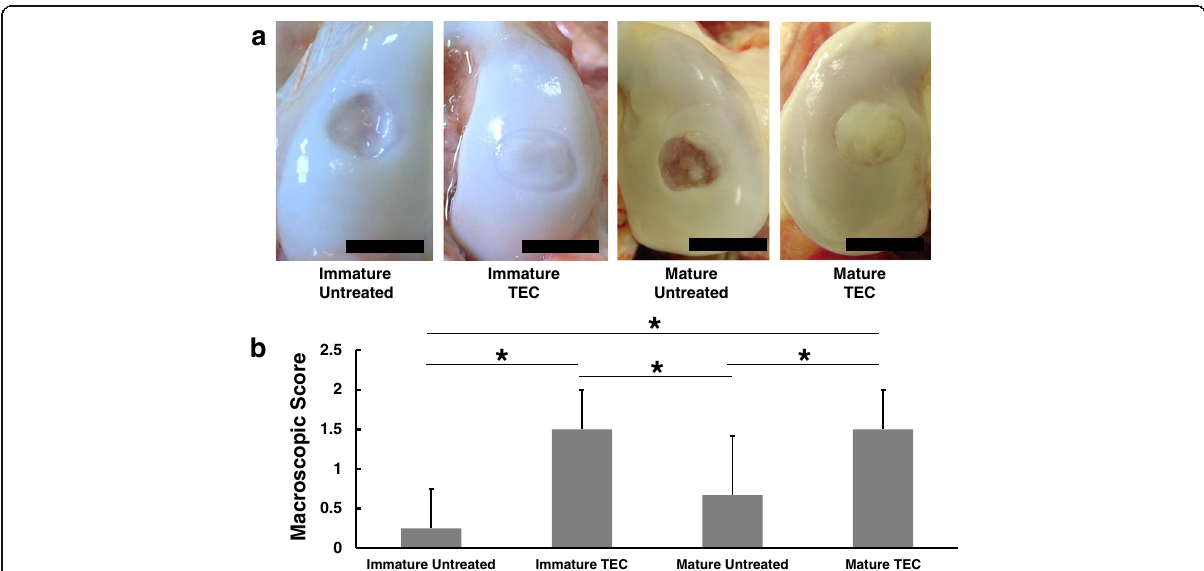
Fig. 3 a Macroscopic view of a chondral lesion treated with or without TEC at 6 months post-implantation. Bar = 10 mm. b Macroscopic score of the repair tissue at 6 months. Regardless of skeletal maturity, the TEC group shows significantly higher scores than does the untreated group. * ; p < 0.05. Quoted and modified from Shimomura et al. , Biomaterials